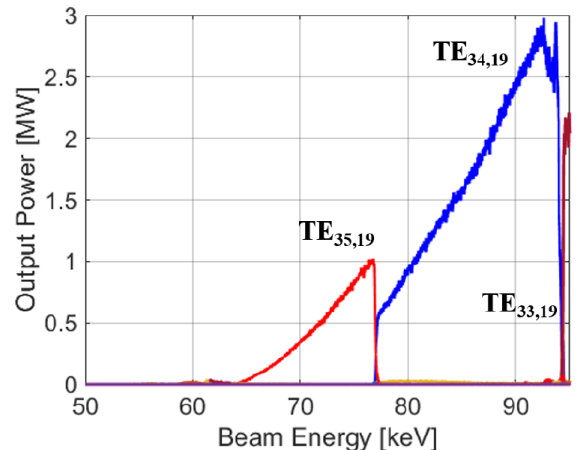
Fig. 6. Realistic start-up scenario with the existing coaxial cavity at 8.15 T and I beam = 70 A without non-linear uptaper using the magnetic field profile proposal from the new SC magnet and the gun parameters from the new coaxial MIG.